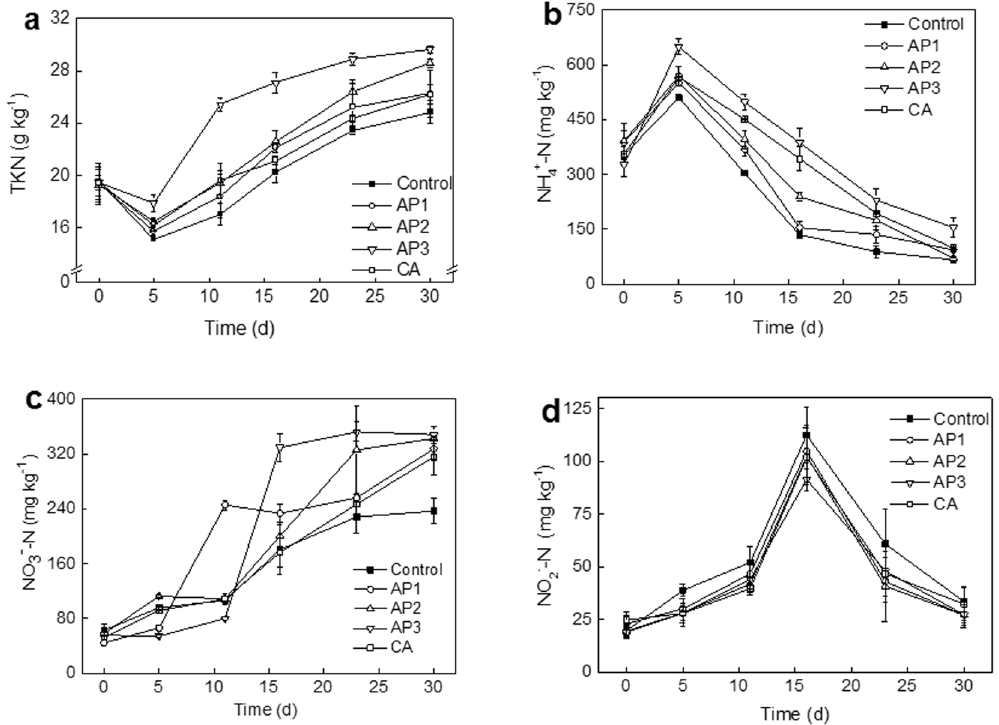
Figure 3. Effects of additives on TKN ( a ), + NH